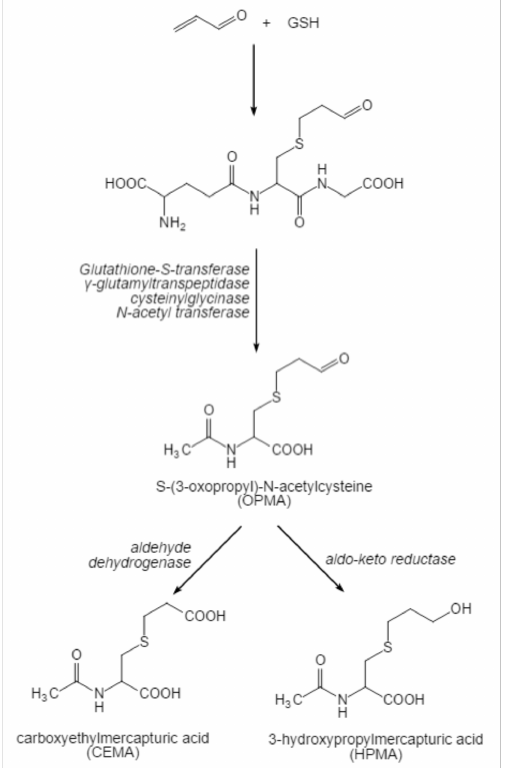
Figure 3. The metabolic process of